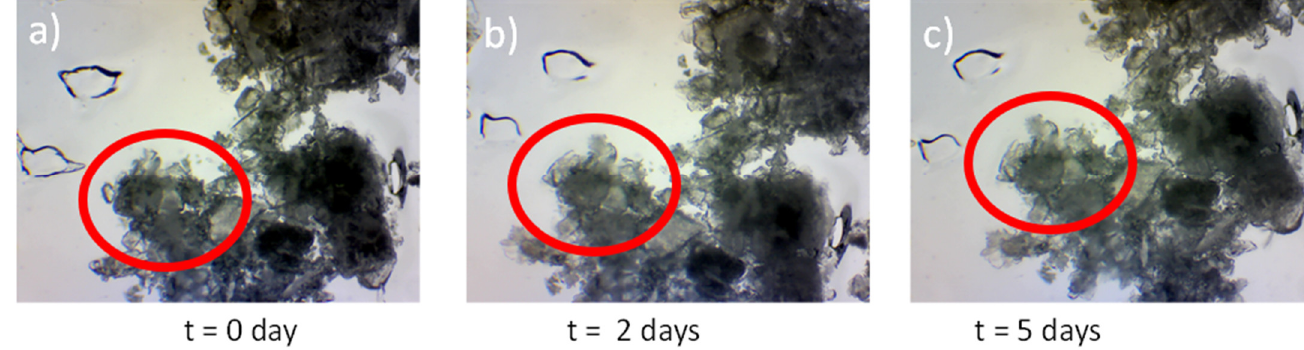
Figure 8. Crystal seeding images of THQ.010 at T = 0 to T = 7 days ( a – c ) showing that there is no crystal growth from the seed (circled) indicating that the formulation is stable.